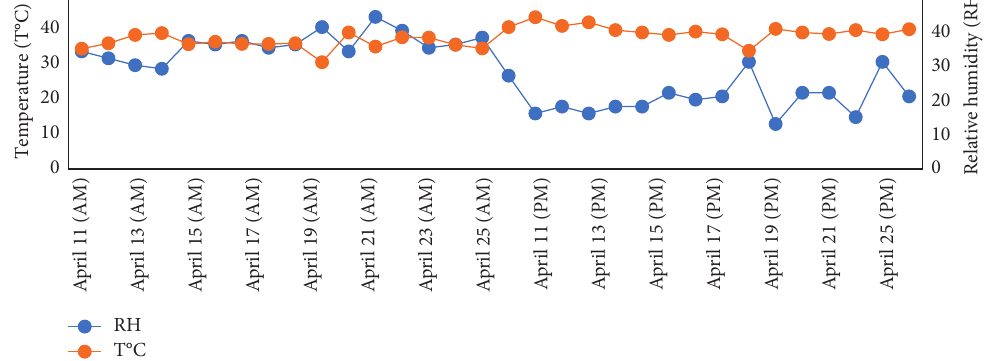
Figure 2: Variation of temperature and relative humidity in screen house during 16 days.